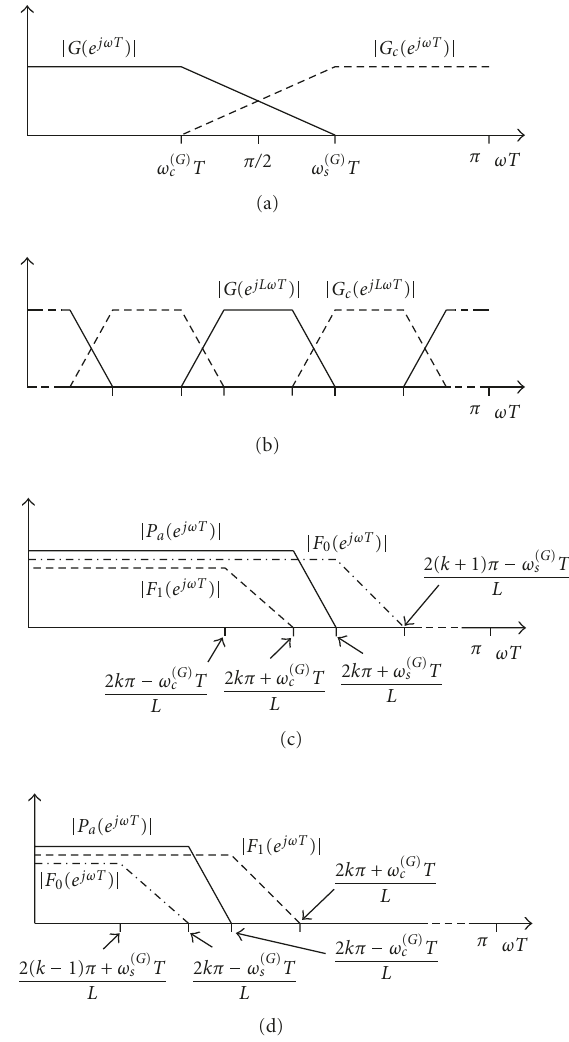
Figure 3: Illustration of magnitude functions in the FRM approach, where (c) and (d) show the two alternatives Case 1 and Case 2, re-